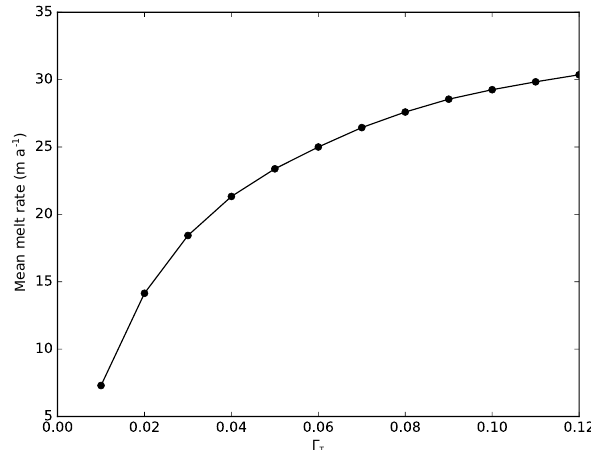
Figure 9. Example results from a series of POP2x simulations of Ocean0 showing the dependence of the mean melt rate (cid:104) m w (cid:105) aver- aged over locations below z d = − 300m and over the final 6 months of the simulation for various values of the turbulent heat-transfer coefficient (cid:48) T . Based on these results, the value (cid:48) T ≈ 0 . 11, corre- sponding to a mean melt rate m w ≈ 30ma − 1 , was used for subse- quent ISOMIP + and MISOMIP1